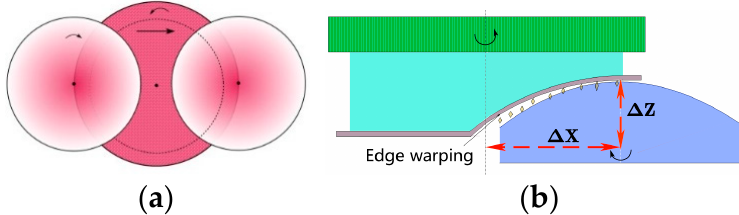
Figure 23. Change in polishing tracking: ( a ) polishing path; ( b ) edge warping.